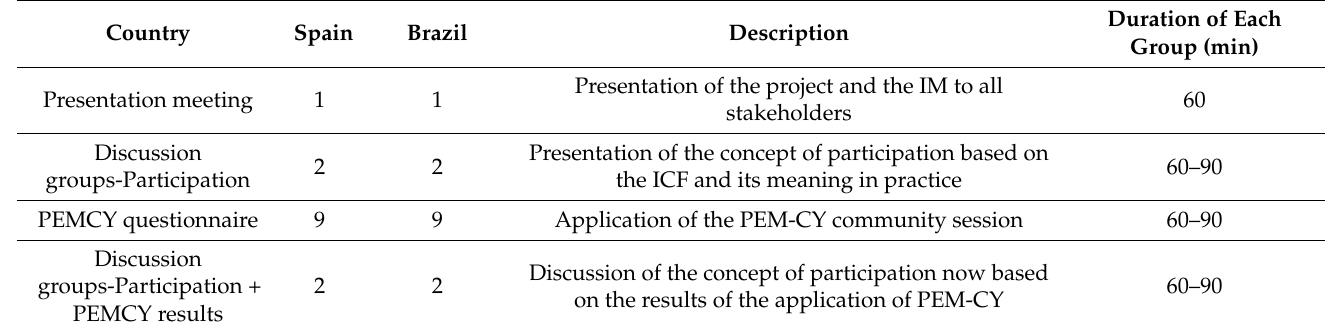
Table 2. Duration and content of the meetings that will be held in the research project in both